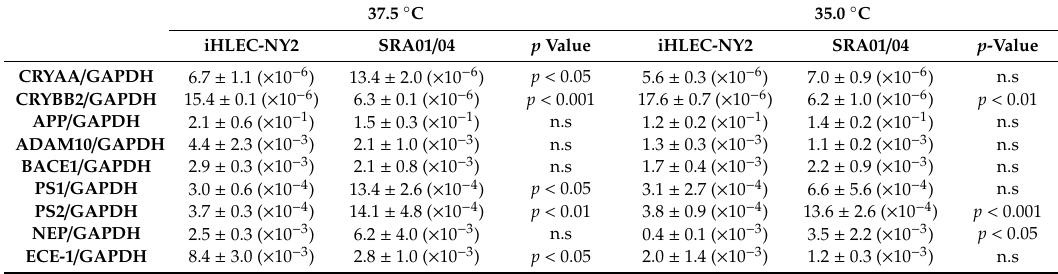
Table 1. The comparison of the gene expressions in iHLEC-NY2 and SRA01 / 04 at 37.5 ◦ C and 35.0 ◦